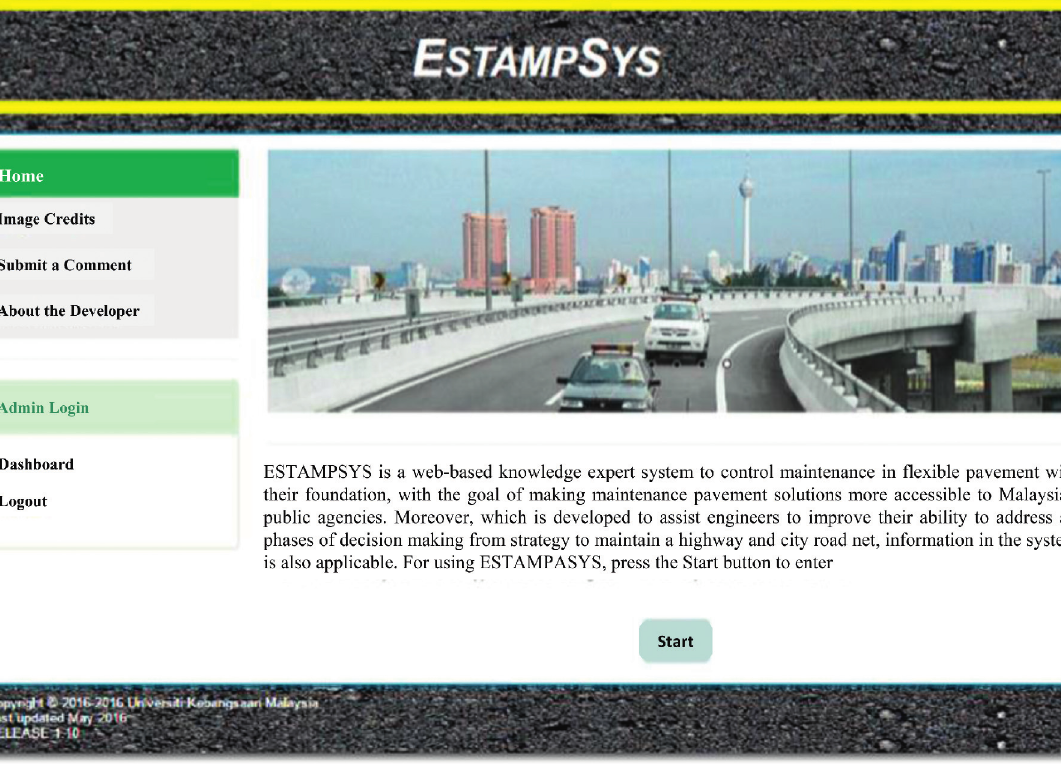
Figure 5: Screenshot of the ESTAMPSYS start page.